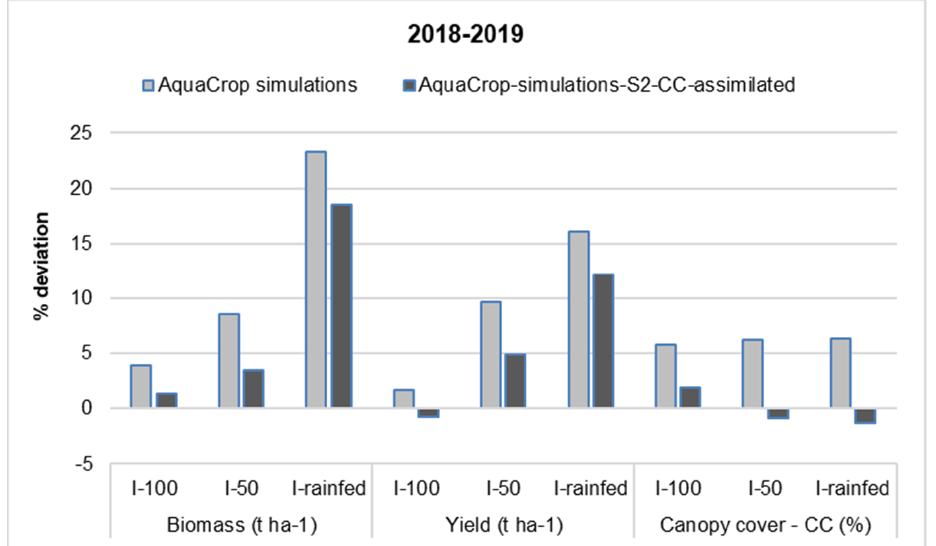
Figure 4. Percentage of deviation between simulated and measured variables before and after S2-CC assimilation into AquaCrop for 2018–2019.